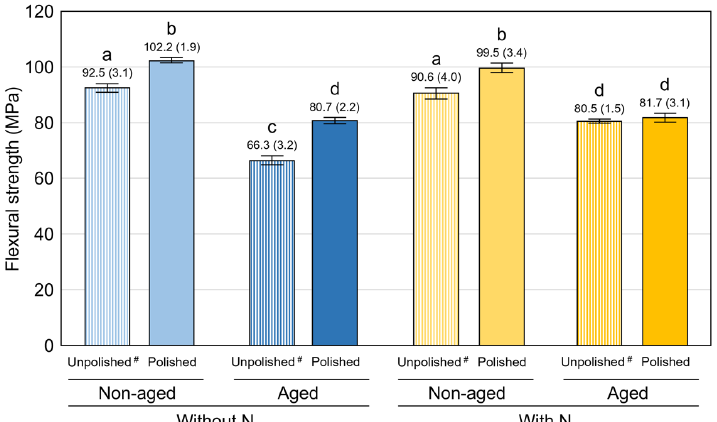
Table 3. Mean values and standard deviations of DC, W SP , and W SL , and results of 1-way ANOVA statistical analysis.